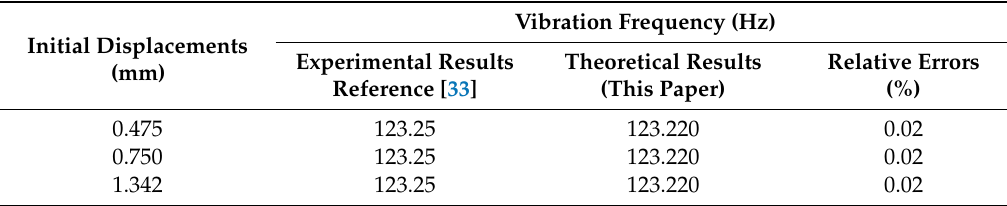
Table 8. Frequencies of experimental and theoretical